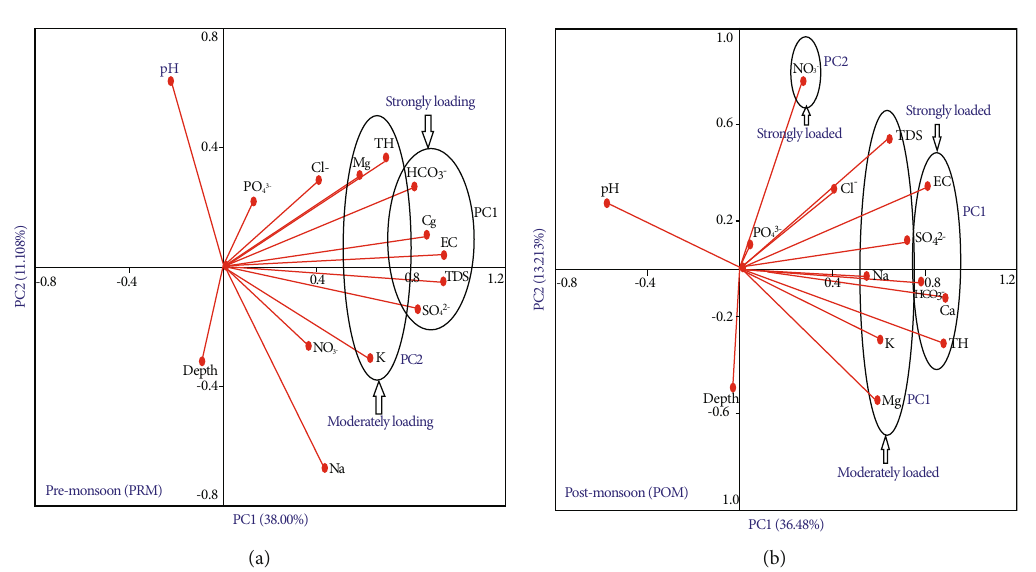
Figure 6: Biplot (axis PC1 and PC2) of robust principal component analysis for (a) premonsoon (PRM) and (b) postmonsoon (POM) sampling